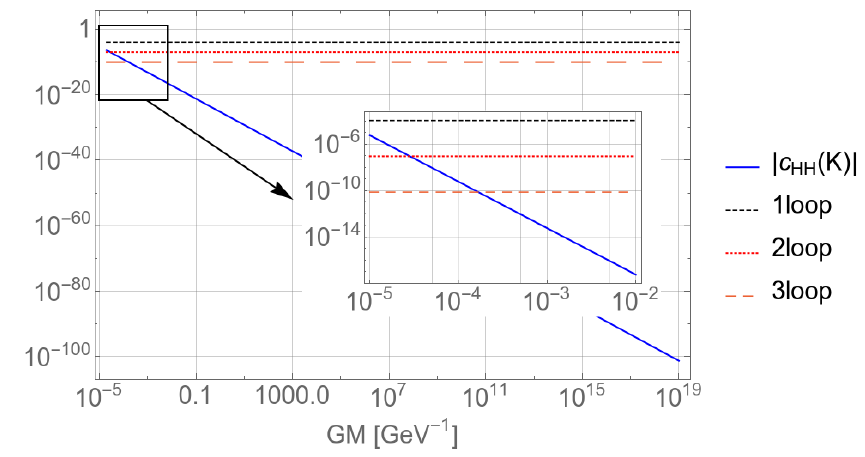
Figure 1 . The contribution of the gravity induced part of the c HH coe(cid:14)cient to the Higgs quartic coupling in the black hole background. j c HH ( K ) j = j (cid:0) 1 M is the black hole mass and loops prefactors are given by the formula nloop= (cid:21) the plot we chose (cid:21) HX = 0 : 25, (cid:21) H = 0 : 13 and m X = 10TeV. The plot was made in the double logarithmic